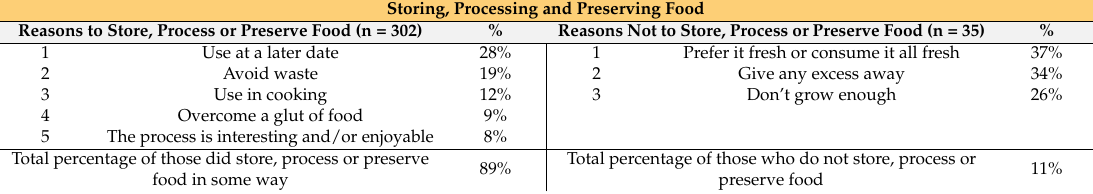
Figure 2. The food processing, storing or preserving techniques used by Edible Gardens survey respondents in the past year. ‘Other’ mostly refers to other uncommon methods, for example, salting olives or making wine, beer and cordial. The options were not mutually exclusive. Table 5. The reasons to and to not store, process or preserve harvested